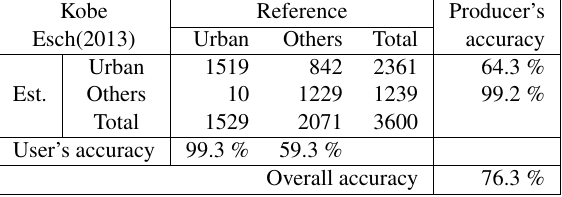
Table 2. Accuracy of extracted urban areas in study area 1 by using the method of Esch et al.(2013)